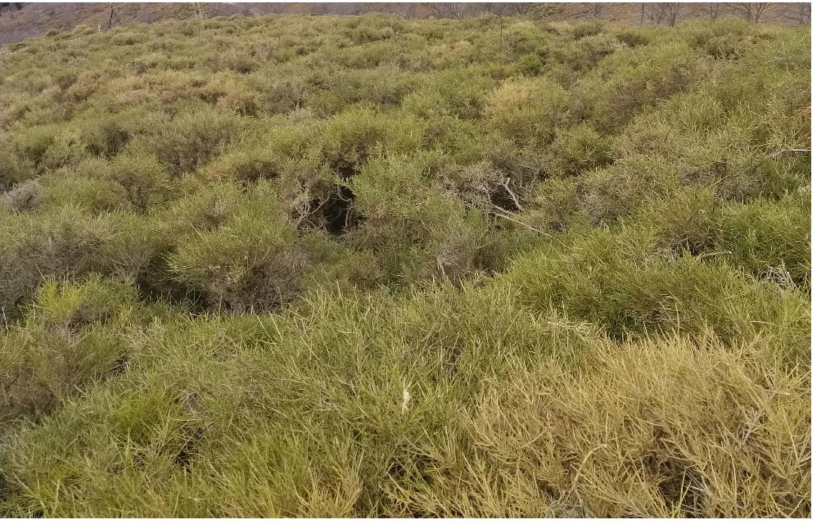
Figure 2. Genista salzmannii vegetation (October 2021 experiment site).